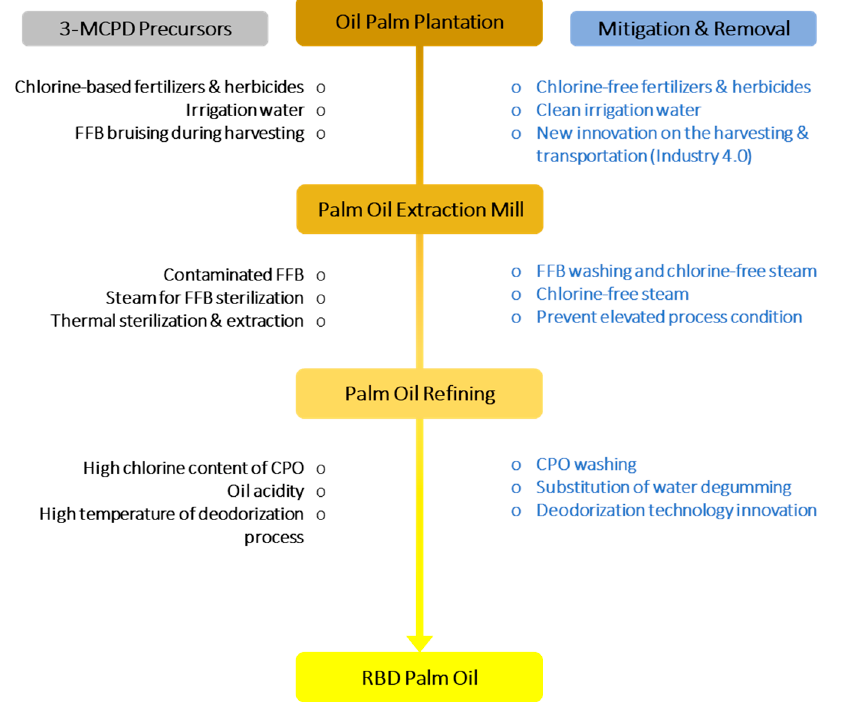
Figure 3. Proposed pathway for mitigation and removal of 3-MCPD from as early as in oil palm plantation management to the refining crude palm oil (CPO) process.